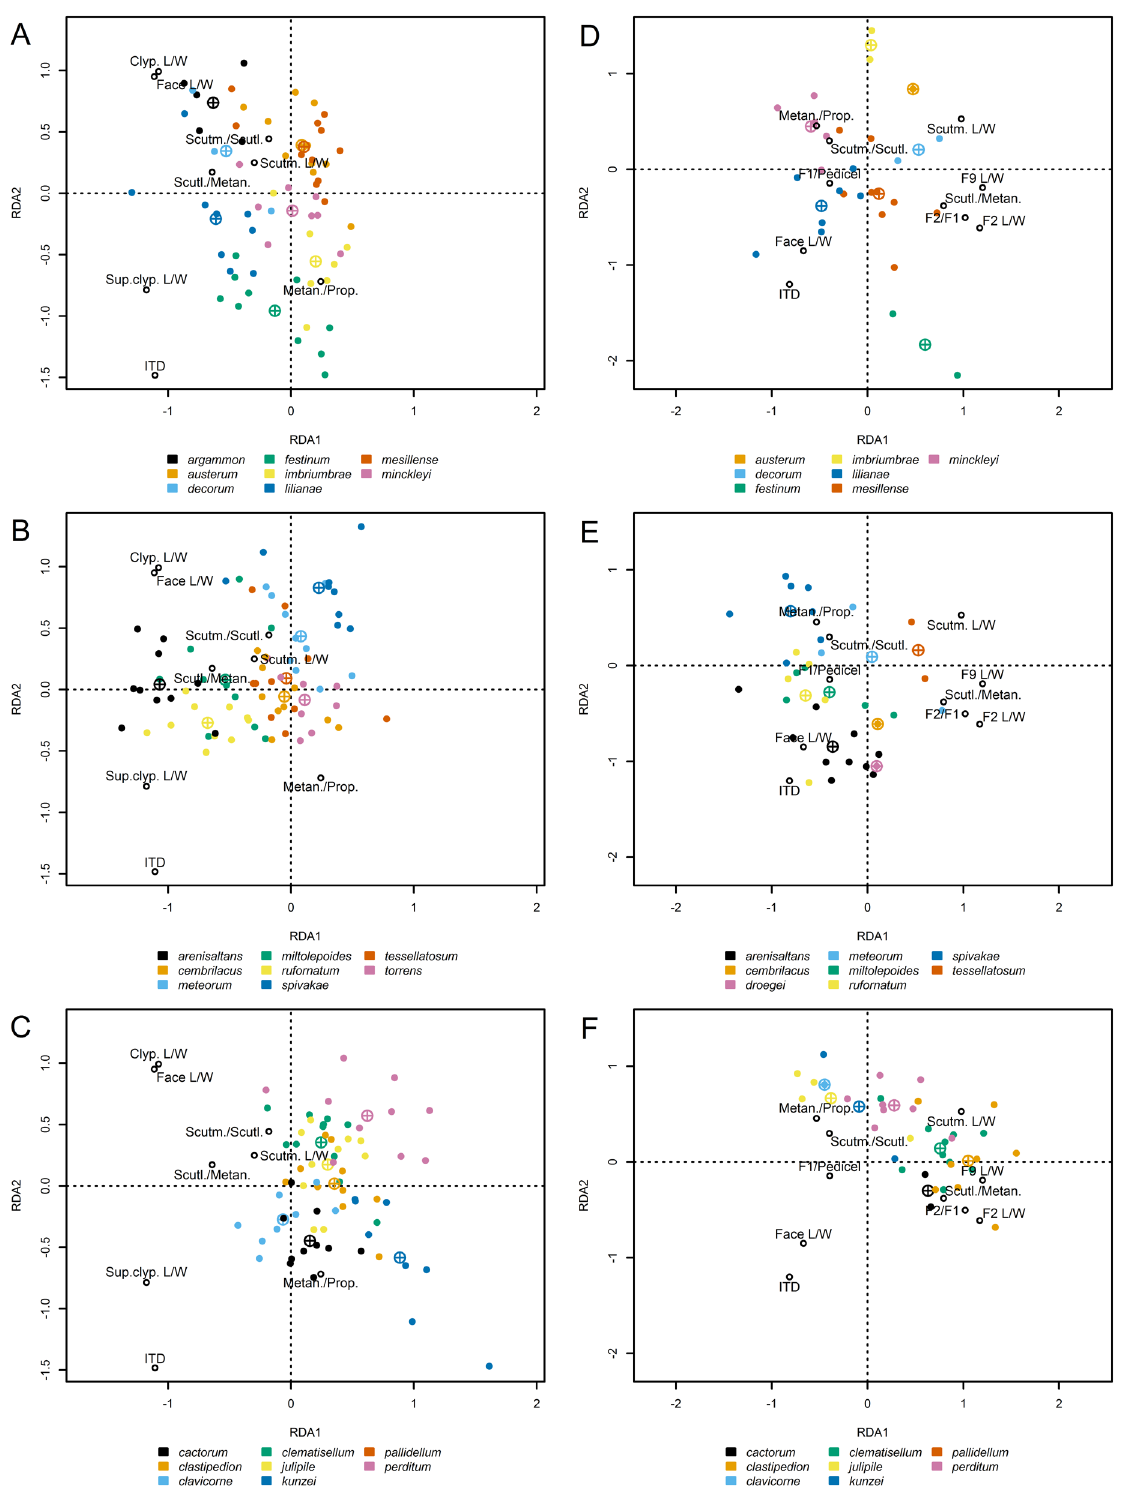
Fig. 5. Ordination plot of redundancy analysis of morphometrics. A–C . ♀♀. D–F . ♂♂. A–C and D–F depict the same plot and analysis; three groups of species are each shown separately for ease of interpretation. Characters are represented by open black circles. Crosshairs indicate centroids for species